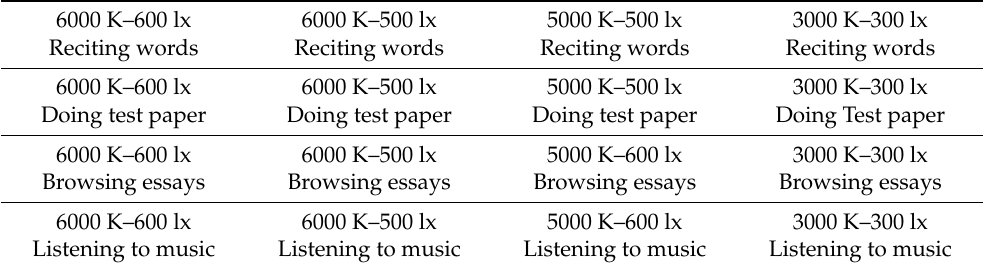
Table 3. 4 × 4 experimental